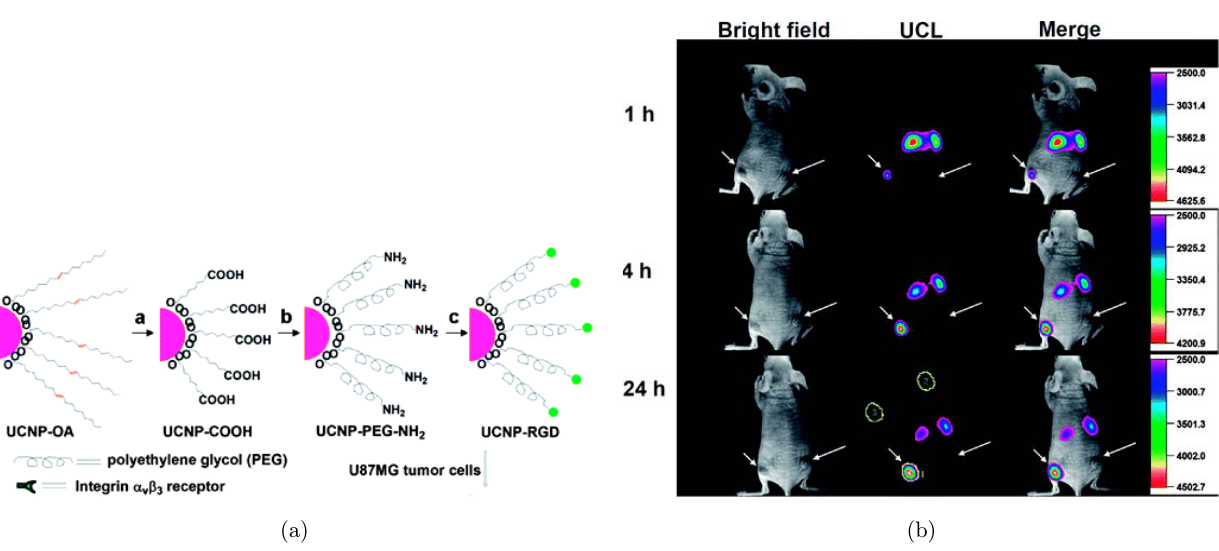
Fig. 4. In vivo tumor-targeted UCL imaging. (a) A scheme showing synthesis of UCNP – RGD. (b) Time-dependent in vivo UCL images of a mouse bearing a U87MG tumor (left hind leg, indicated by short arrows) and a MCF-7 tumor (right hind leg, indicated by long arrows) after intravenous injection of UCNP – RGD. (Reprinted with permission from \High contrast UCL targeted imaging in vivo using peptide-labeled nanophosphors". Copyright (2009) American Chemical Society.)